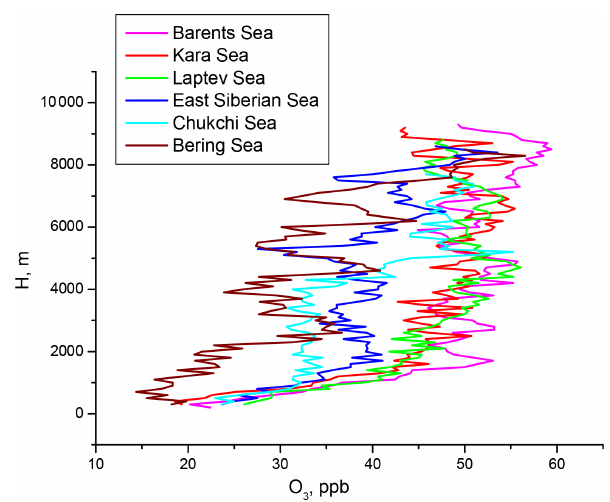
Figure 11. Vertical distribution of ozone over sea areas.